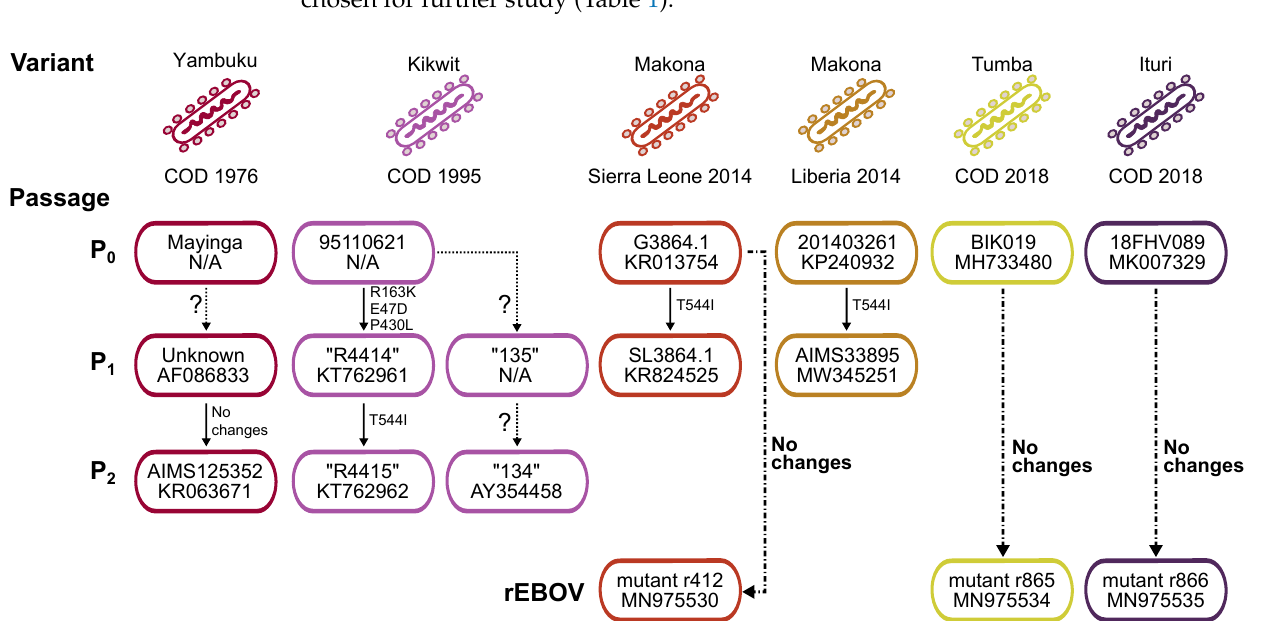
Figure 1. Historical records of natural and synthetic Ebola virus (EBOV) isolates used in this study. EBOV variants are uniquely colored; country of origin and year of collection are shown. Passage information is provided: P0 indicates the natural isolate; P1 and P2 indicate subsequent passages in model organisms. An identifier and GenBank accession number, if available, is provided. The question marks between passages indicate the lack of sequencing information verifying new changes. In the case that sequencing was performed, changes in the glycoprotein (GP 1,2 ) are shown or the arrow is labeled with “no changes”. Isolates recovered using reverse genetics (rEBOV) are also shown. Table 1. Recombinant EBOV/Mak genotypes used in this study as templates for the on-demand pipeline. Designation for This